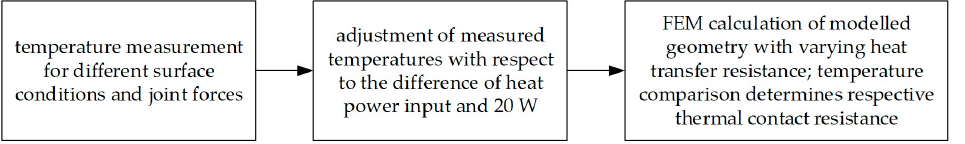
Figure 13. Approach for determination of thermal contact resistance based on experimentally mea- sured